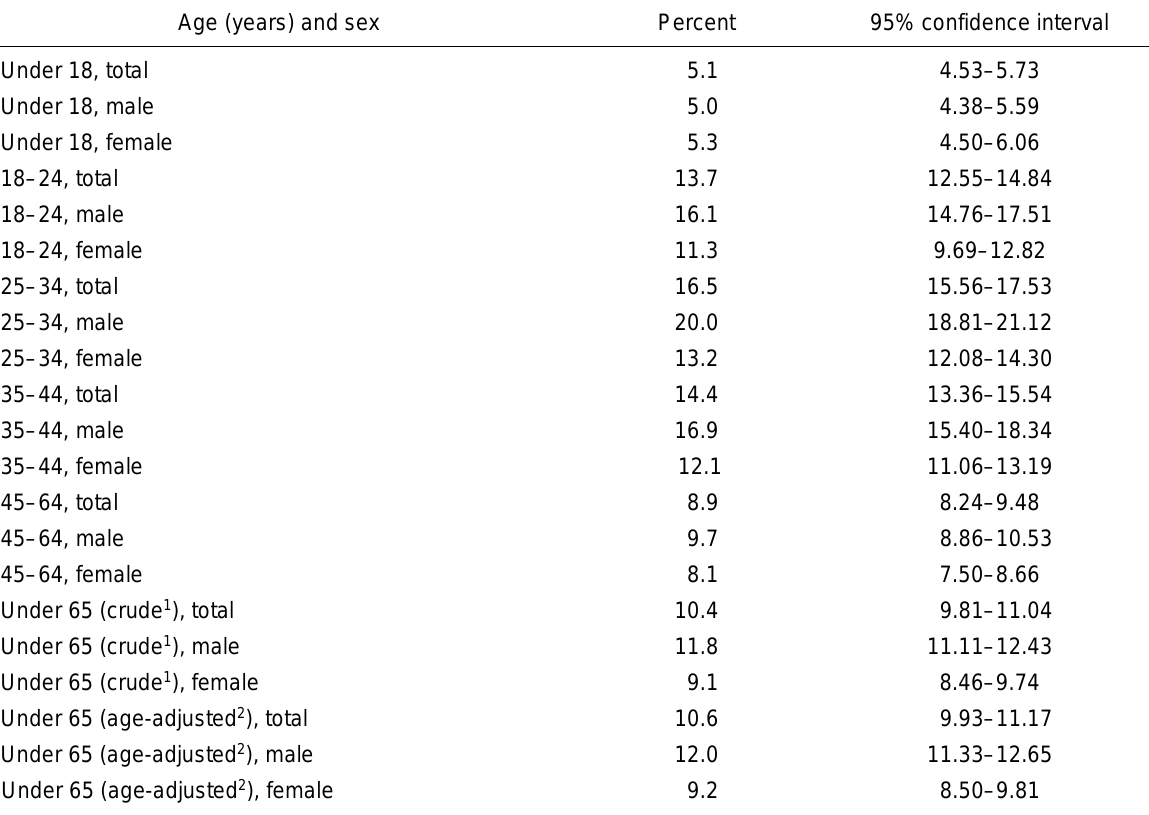
Data table for Figure 1.2. Percentage of persons under age 65 without health insurance coverage at the time of interview, by age group and sex: United States,